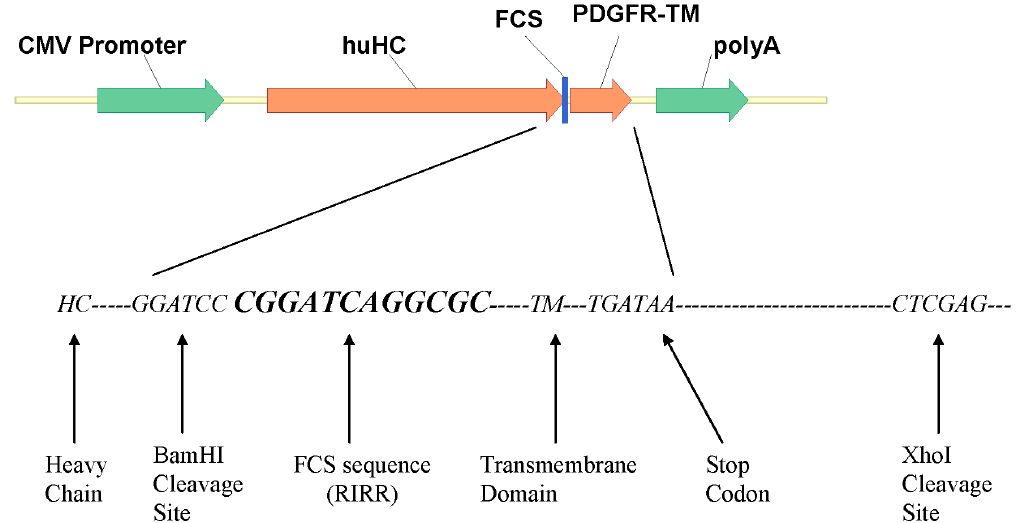
Figure 2. FCS diagram. The nucleotide sequence coding for Furin cleavage site RIRR is inserted between heavy chain and trans-membrane domain in frame by PCR assembling.